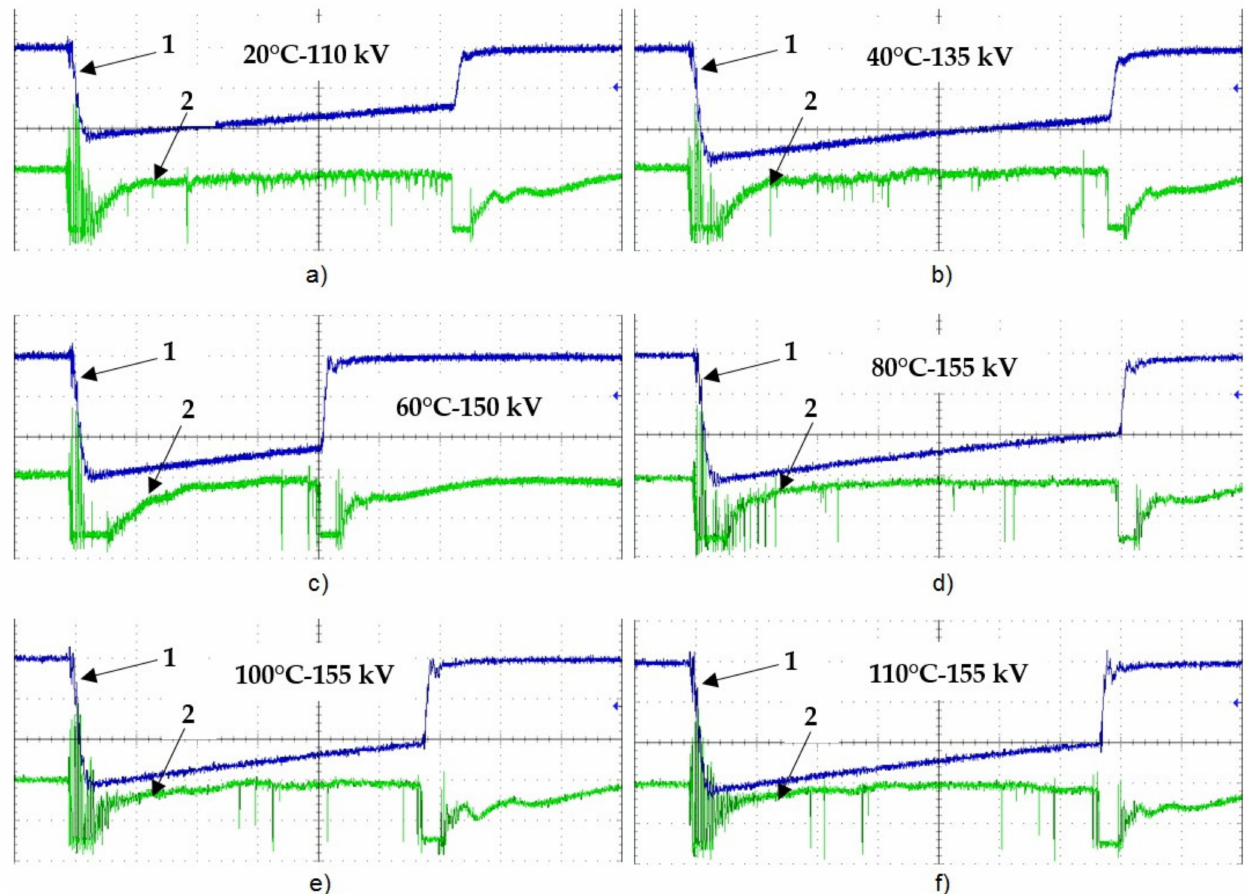
Figure 7. Examples of the oscillograms for subsequently analyzed temperatures: 1, voltage [50 kV/div.]; 2, light [relative units]; time base, 4 µ s/div.: ( a ) 20 ◦ C, ( b ) 40 ◦ C, ( c ) 60 ◦ C, ( d ) 80 ◦ C, ( e ) 100 ◦ C, ( f ) 110 ◦